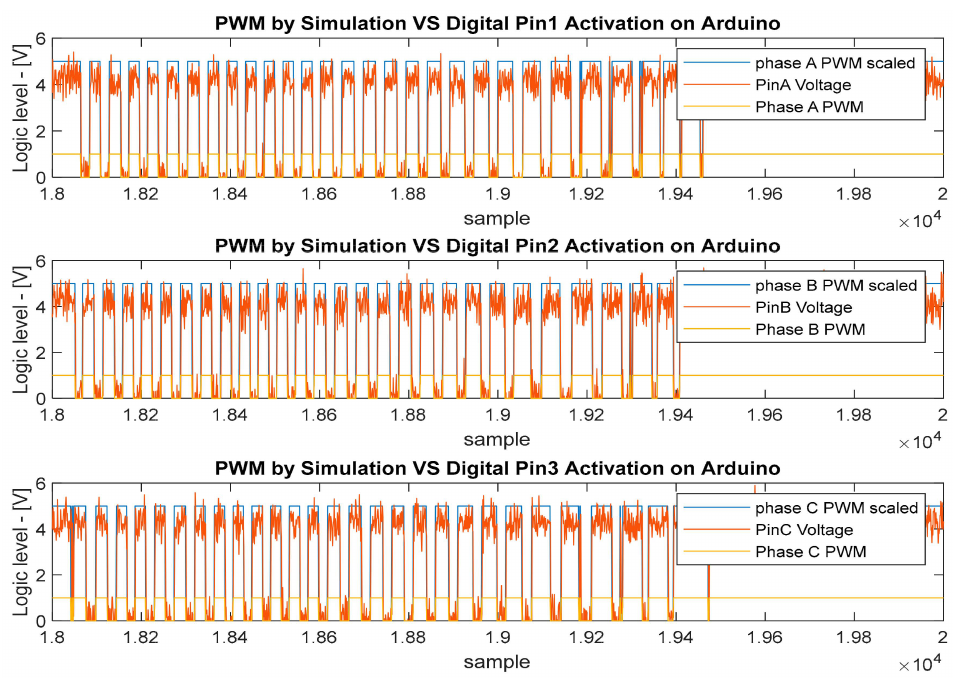
Figure 15. Comparison between the logical signal in output from the pulse width modulation (PWM) block in the simulated scheme and the physical measures of the driven Arduino digital pins (sample time of 0.0001 s) in a processor-in-the-loop validation test